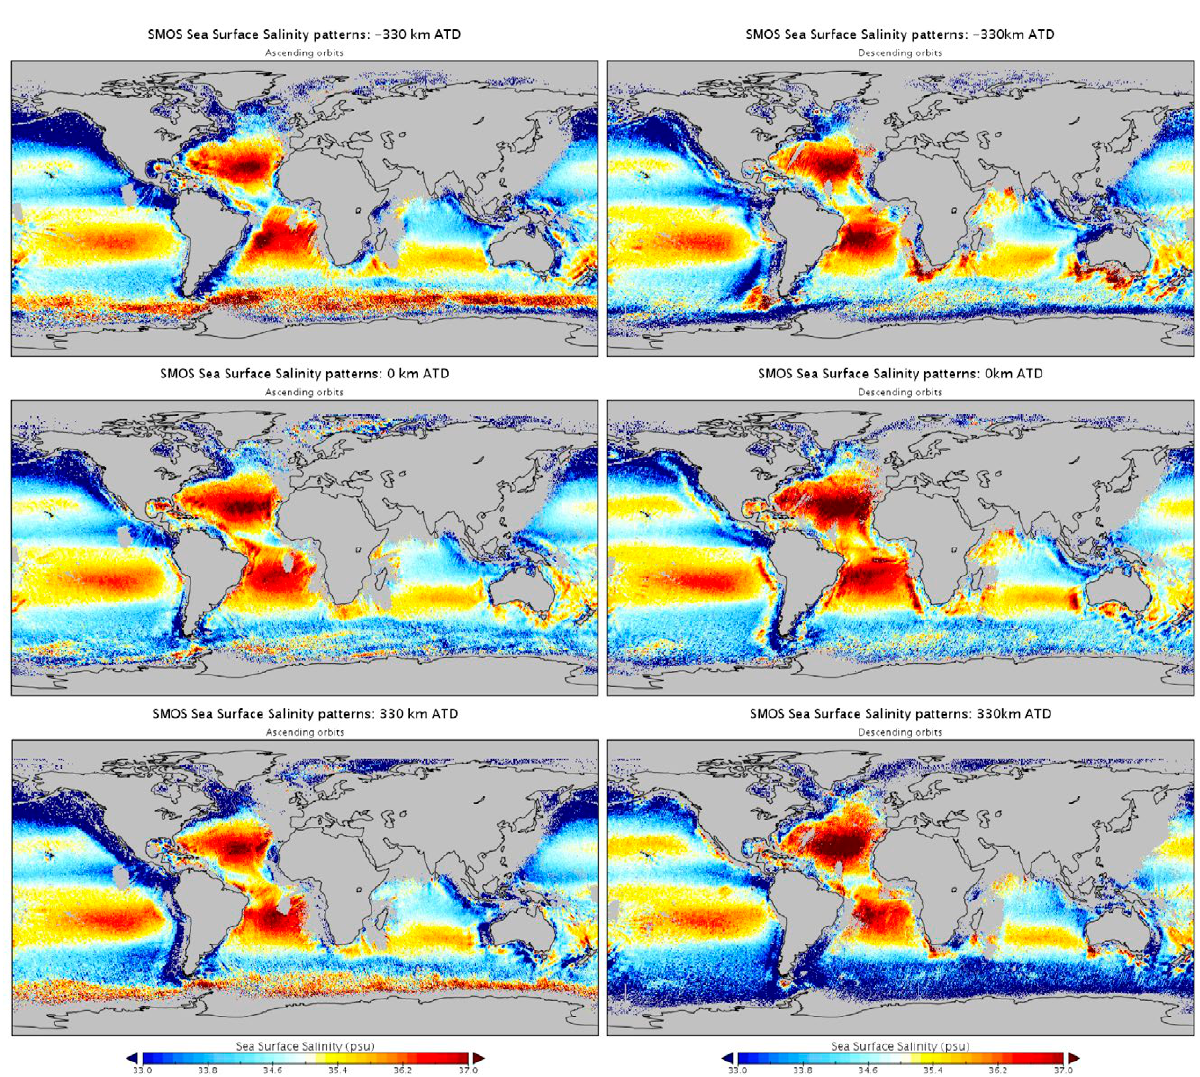
Fig. 5. – SMOS average salinity maps depending on the across-track distance or distance from the grid point to the centre of the